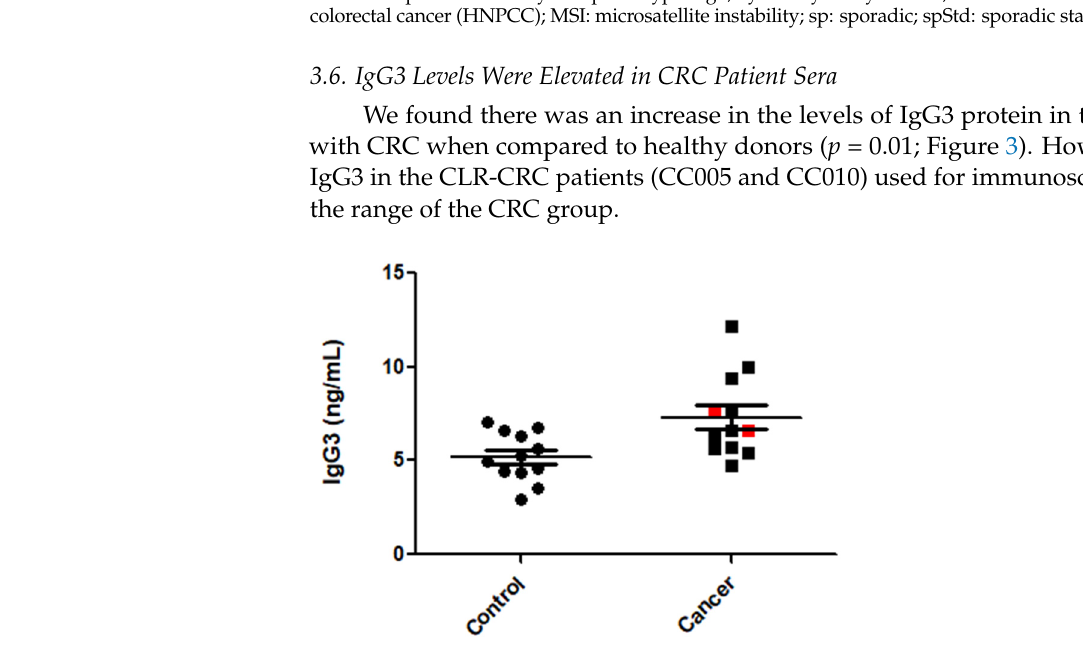
Figure 2. Immunolabelling of intracellular IgG3 in CRC samples. Examples of staining include sin- gle cells, strong in stroma (HROC086) and parenchyma (HROC0252_Tu2) and very slight back- ground staining (HROC117).